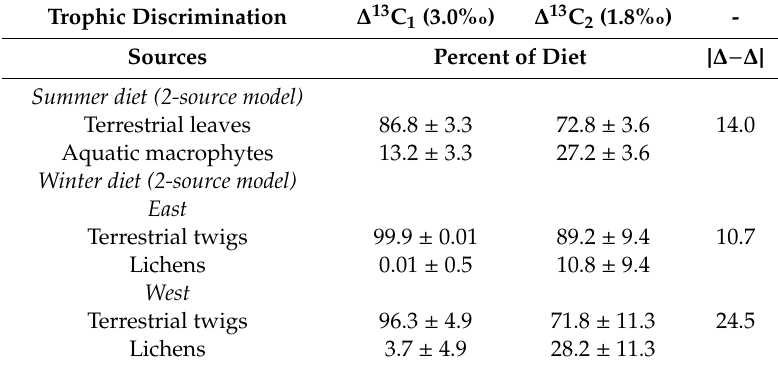
Table 2. Trophic shift ( ∆ δ 13 C) influence on the proportional estimate of food sources to moose diet at Isle Royale National Park, USA.